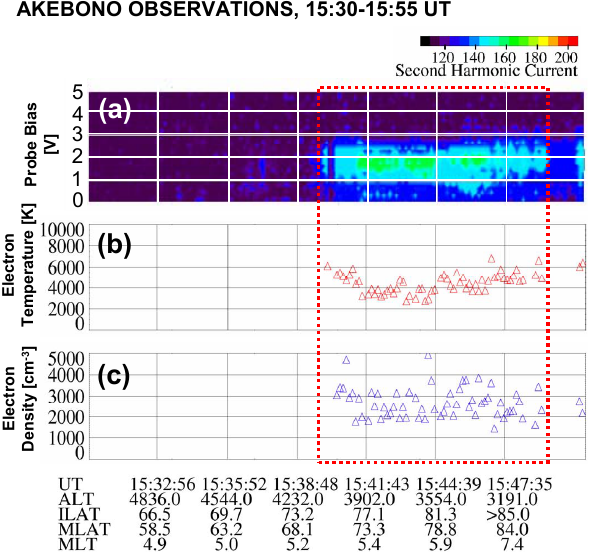
Fig. 2. (a) Probe voltage versus time spectrogram of second har- monic current, (b) electron temperature, and (c) electron density on 20 March 2002 derived from TED